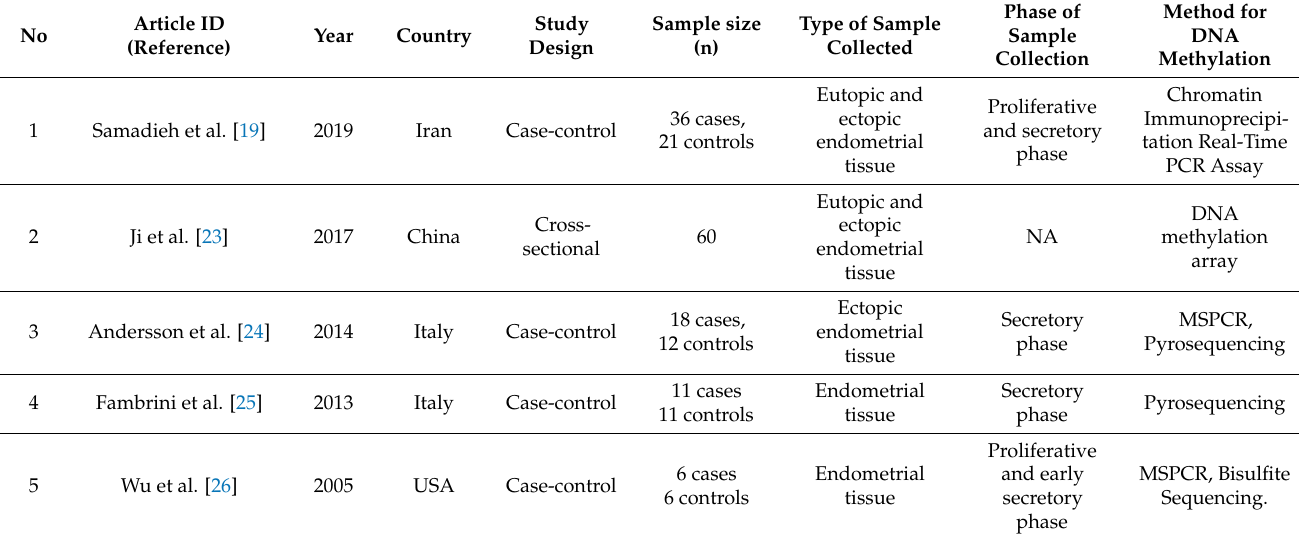
Table 1. Major characteristics of the included studies.